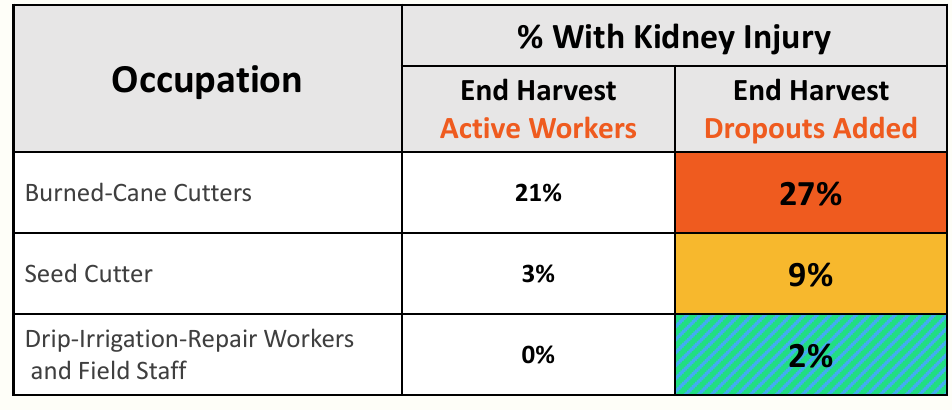
Figure 7. Baseline cross-harvest rates of kidney injury by job type with and without dropouts (adapted from reference